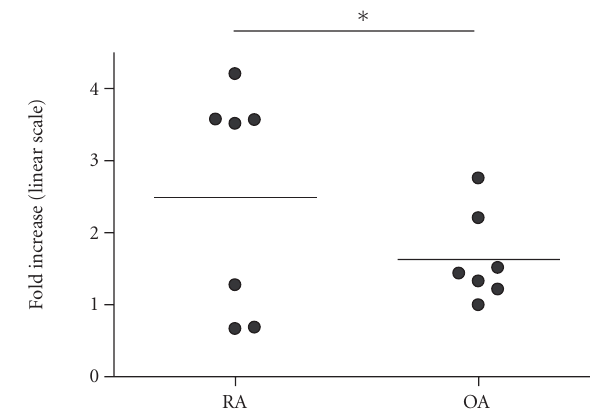
Figure 3: Changes in 15-HETE release into mononuclear cells supernatants after stimulation with 100 ng/mL LPS in individual patients OA-osteoarthritis; RA-rheumatoid arthritis; ∗ p < . 01.